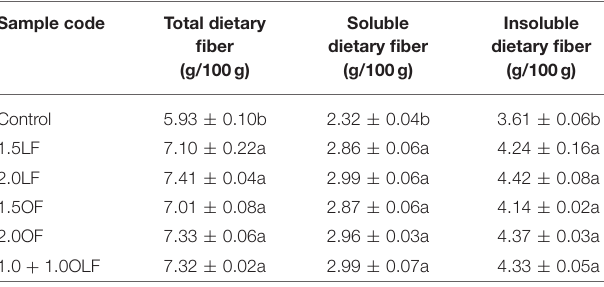
TABLE 3 | Dietary fiber content after baking in bread